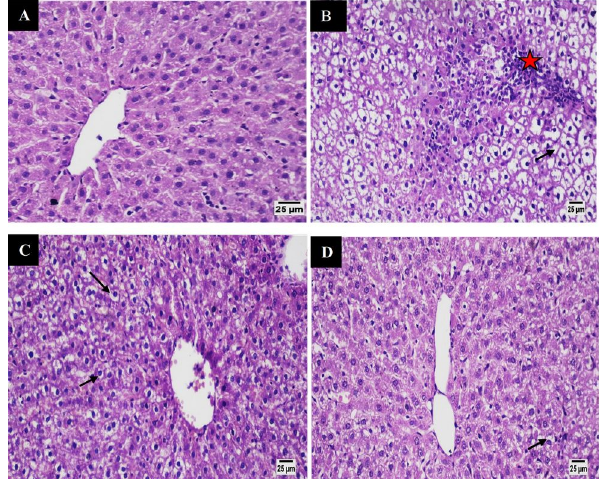
Figure 14. Photomicrographs of H&E-stained sections of liver. ( A ) Control rats showing normal hepatic parenchyma. ( B ) Dia group showing severe vacuolation of the hepatocytes (arrow) with mononuclear inflammatory cells infiltration (red star). ( C ) MTF-treated group showing mild enhancement and mild vacuolation of hepatocytes (arrows). ( D ) MTF-loaded LCS-ALG bead-treated group showing less degree of hepatocellular hypertrophy (arrow).